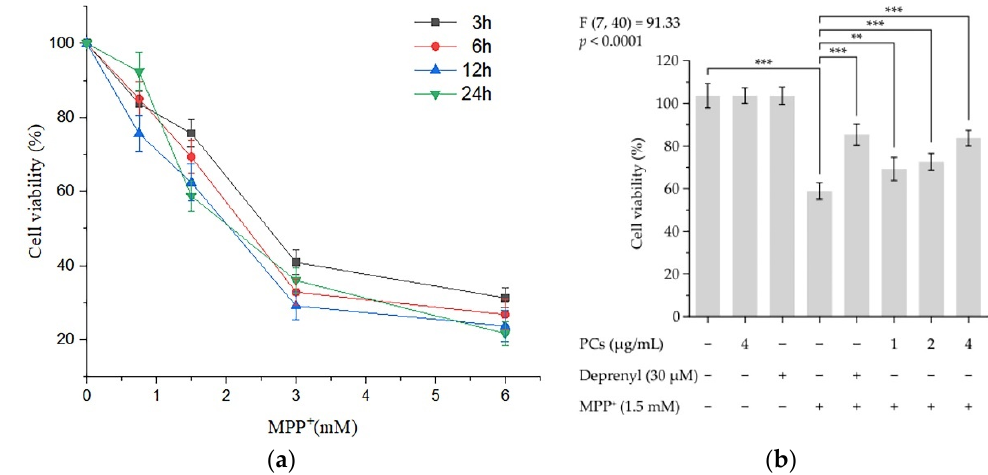
Figure 1. PCs on MPP + -induced cytotoxicity of PC12 cells. Cell viability was detected by CCK-8 assays. ( a ) Cytotoxic effects of MPP + at different concentrations in PC12 cells; ( b ) PC-attenuated MPP + induced decreases in cell viability. F and p values of the one-way analysis of variance are presented above the chart. The results of Tukey’s post hoc test are presented for selected comparisons: **, p < 0.01; ***, p < 0.001; the error bars are standard deviation (SD).